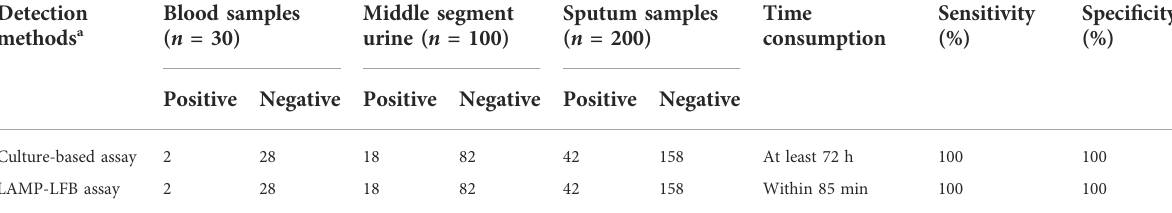
TABLE 3 Comparison of conventional culture and C. albicans -LAMP-LFB methods to identify C. albicans in clinical samples. Detection methods